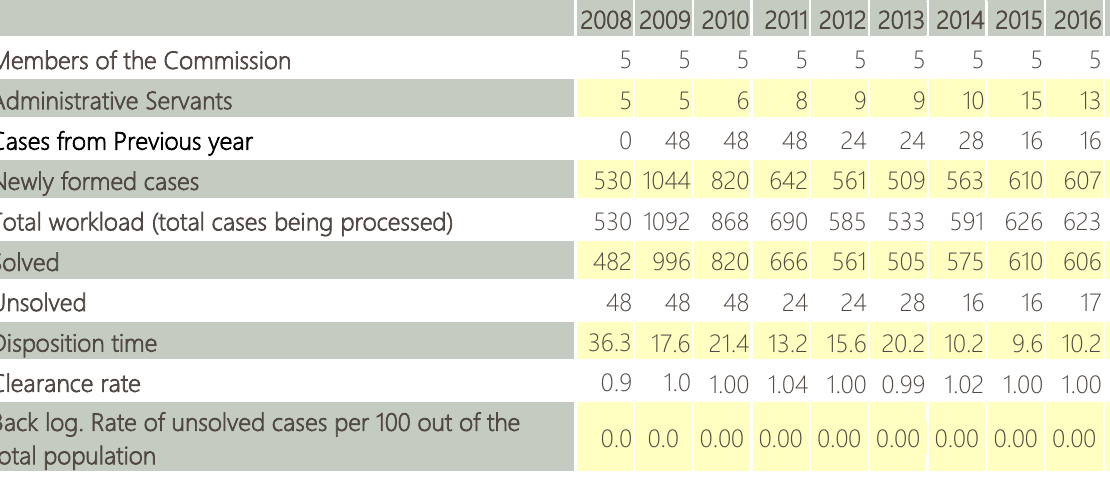
Table 1: State Commission for Appeals in Public